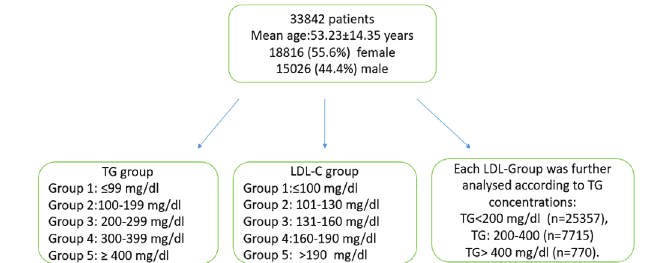
Misclassification of subjects according to calculated LDL-C values.